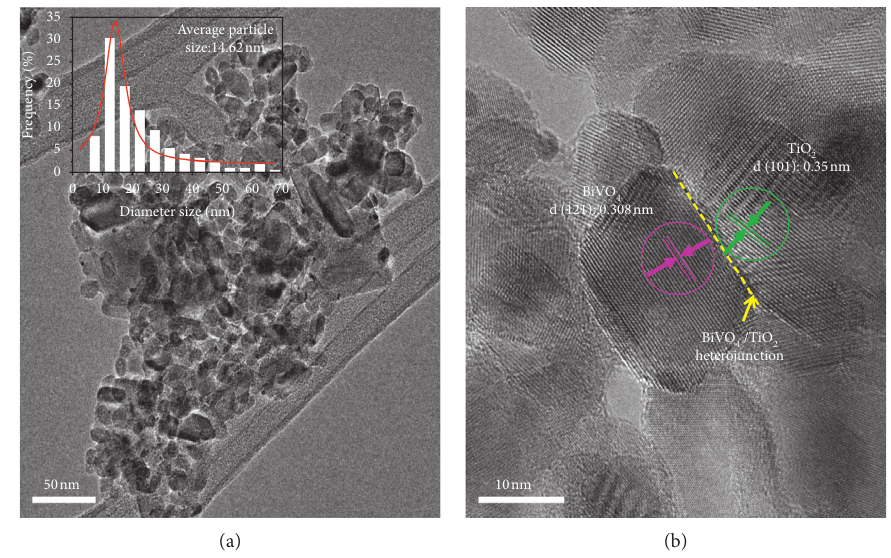
Figure 5: TEM, HRTEM, and average particle size images of 2 wt% BiVO